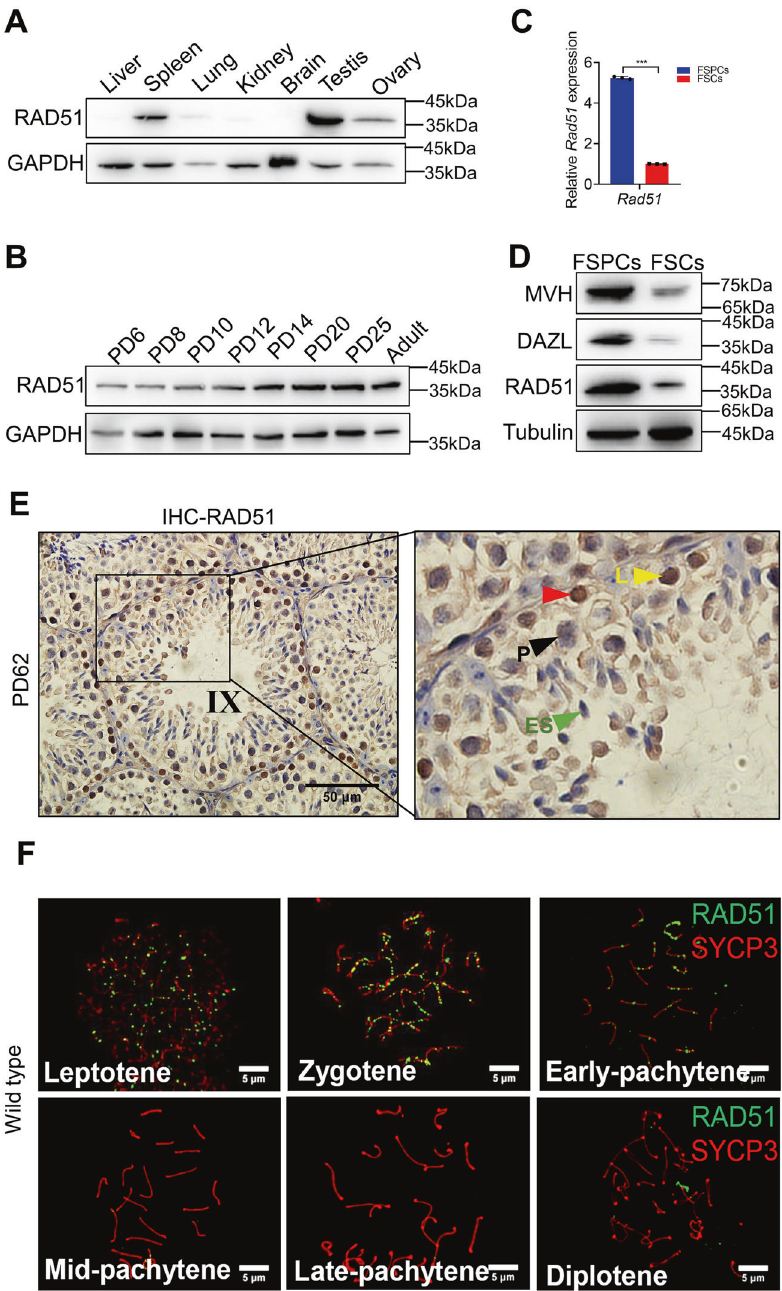
triangle: RAD51 positive cells; L: leptotene spermatocyte; P: pachytene spermatocyte; ES: elongating spermatid). Scale bar is 50 μ m. F Immuno fl uorescence of RAD51 (green fl uorescence) and SYCP3 (red fl uorescence) on chromosome spreads in wild type. Scale bar, 5 μ